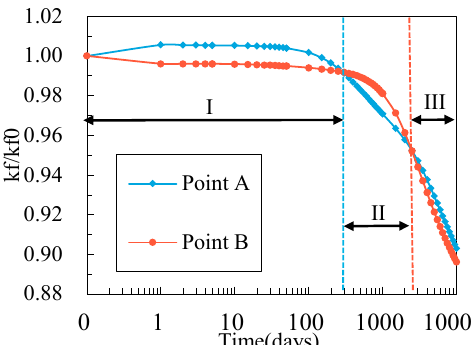
(IW) and Point B is close to the production well (PW).